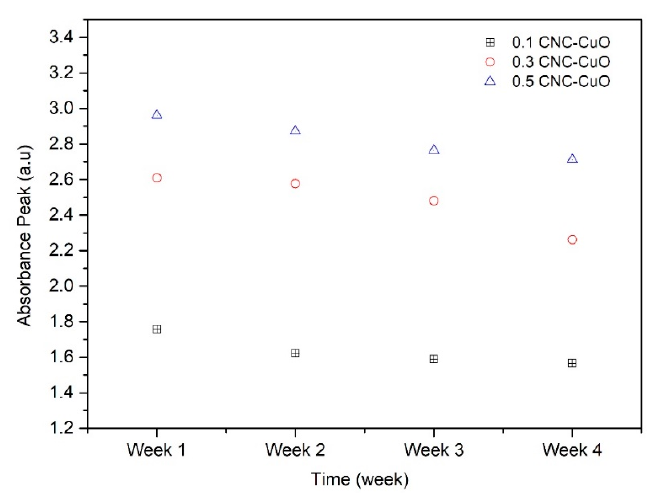
Figure 9. Value of absorbance peak every week.